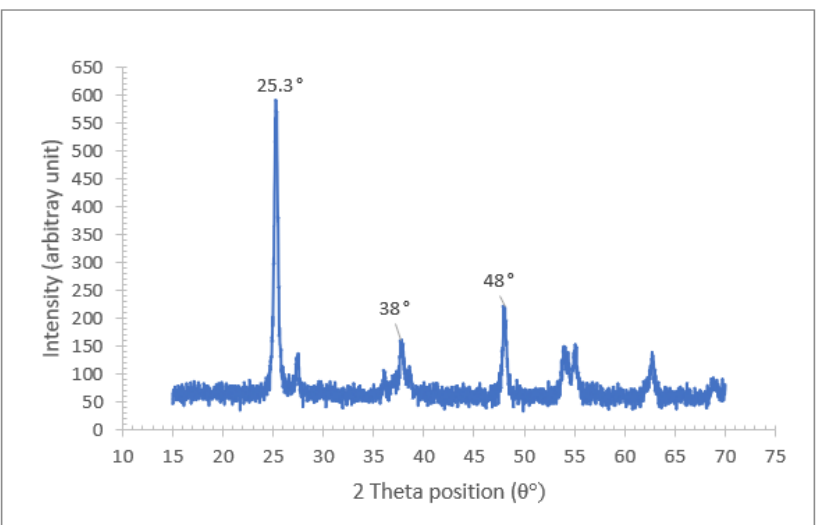
Figure 4. XRD spectra of TiO 2 nanoparticles.